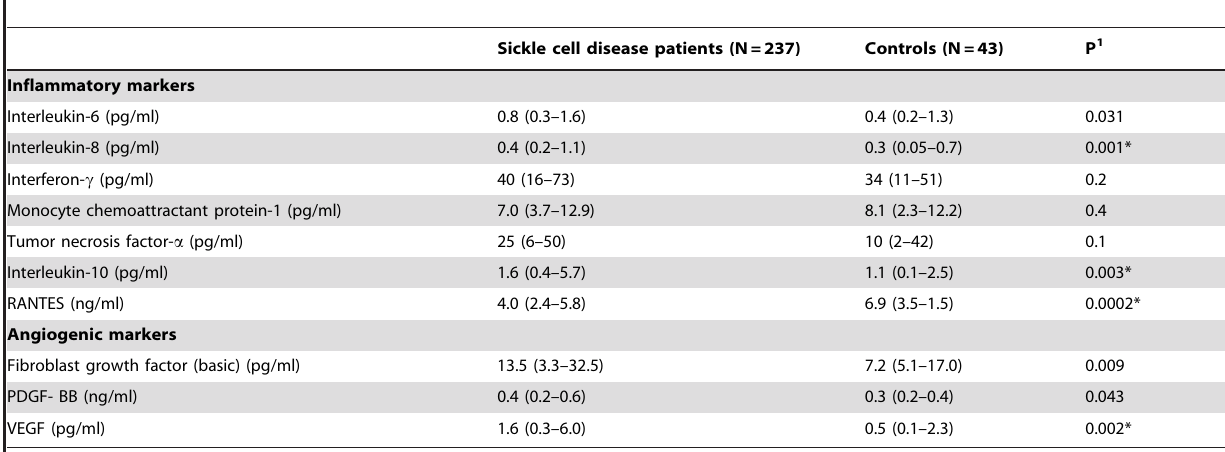
Table 1. Plasma concentrations of biologic markers in patients with sickle cell disease and control participants; results in median (interquartile